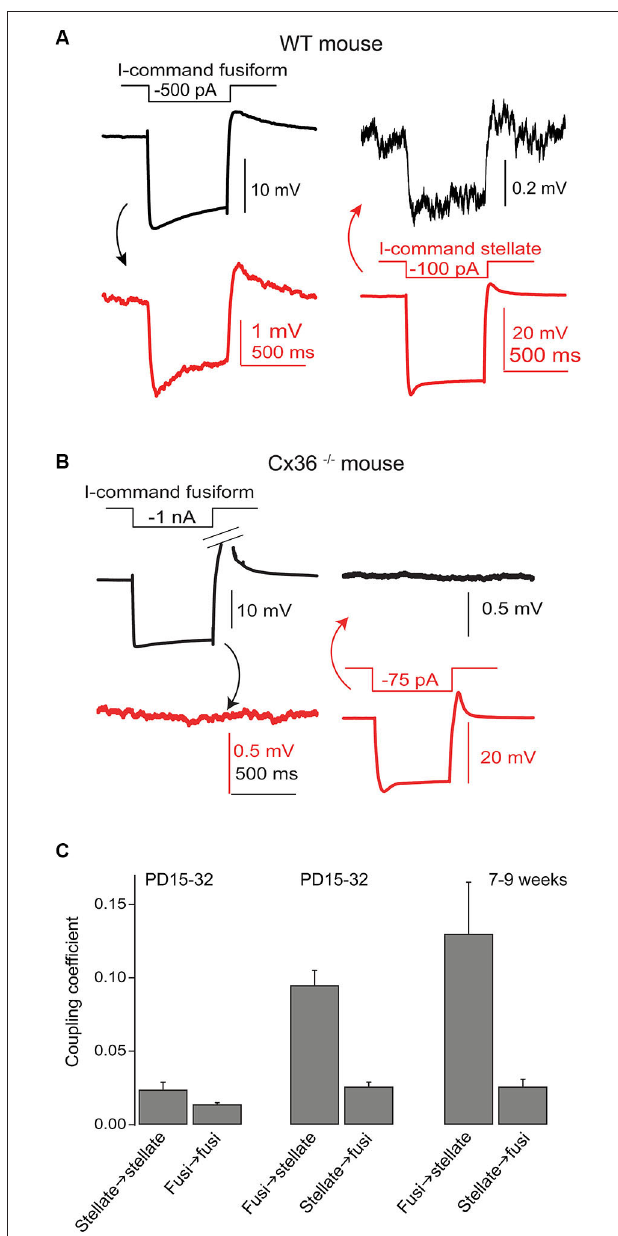
FIGURE 4 | Gap junctions couple SSCs and fusiform cells . (A) Coupling between a recorded SSC and fusiform pair was tested by injection of hyperpolarizing currents in one cell and then the other, as indicated. Hyperpolarizations of smaller amplitude in the postjunctional cell was taken as evidence of coupling. (B) A similar experiment was performed in a Cx36 knockout mouse, and showed no evidence of coupling. (C) Average coupling coefficients reveal bias for transmission from fusiform cell to SSC. This coupling was present in mice up to 9 weeks postnatal. Data adapted from Apostolides and Trussell (2013b).